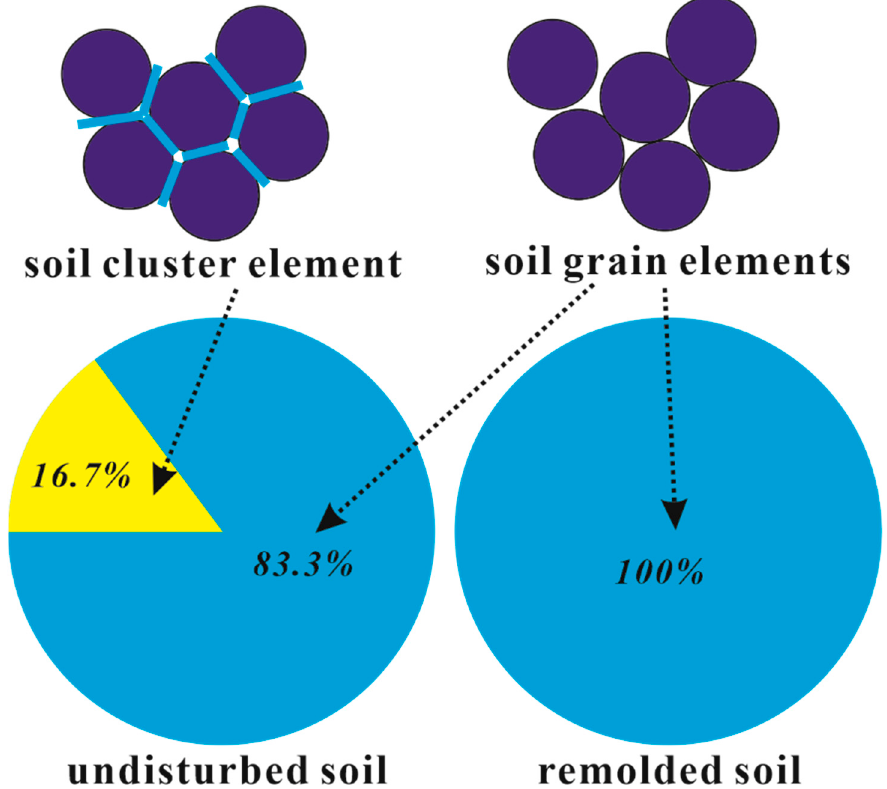
Figure 15. Bonded elements in different soils.